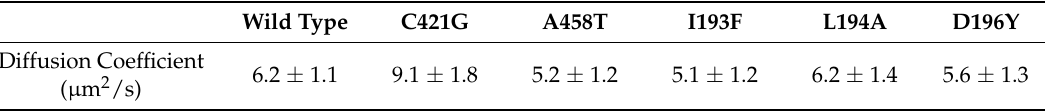
Table 2. Transcriptional activities of hGR wild type and mutants.